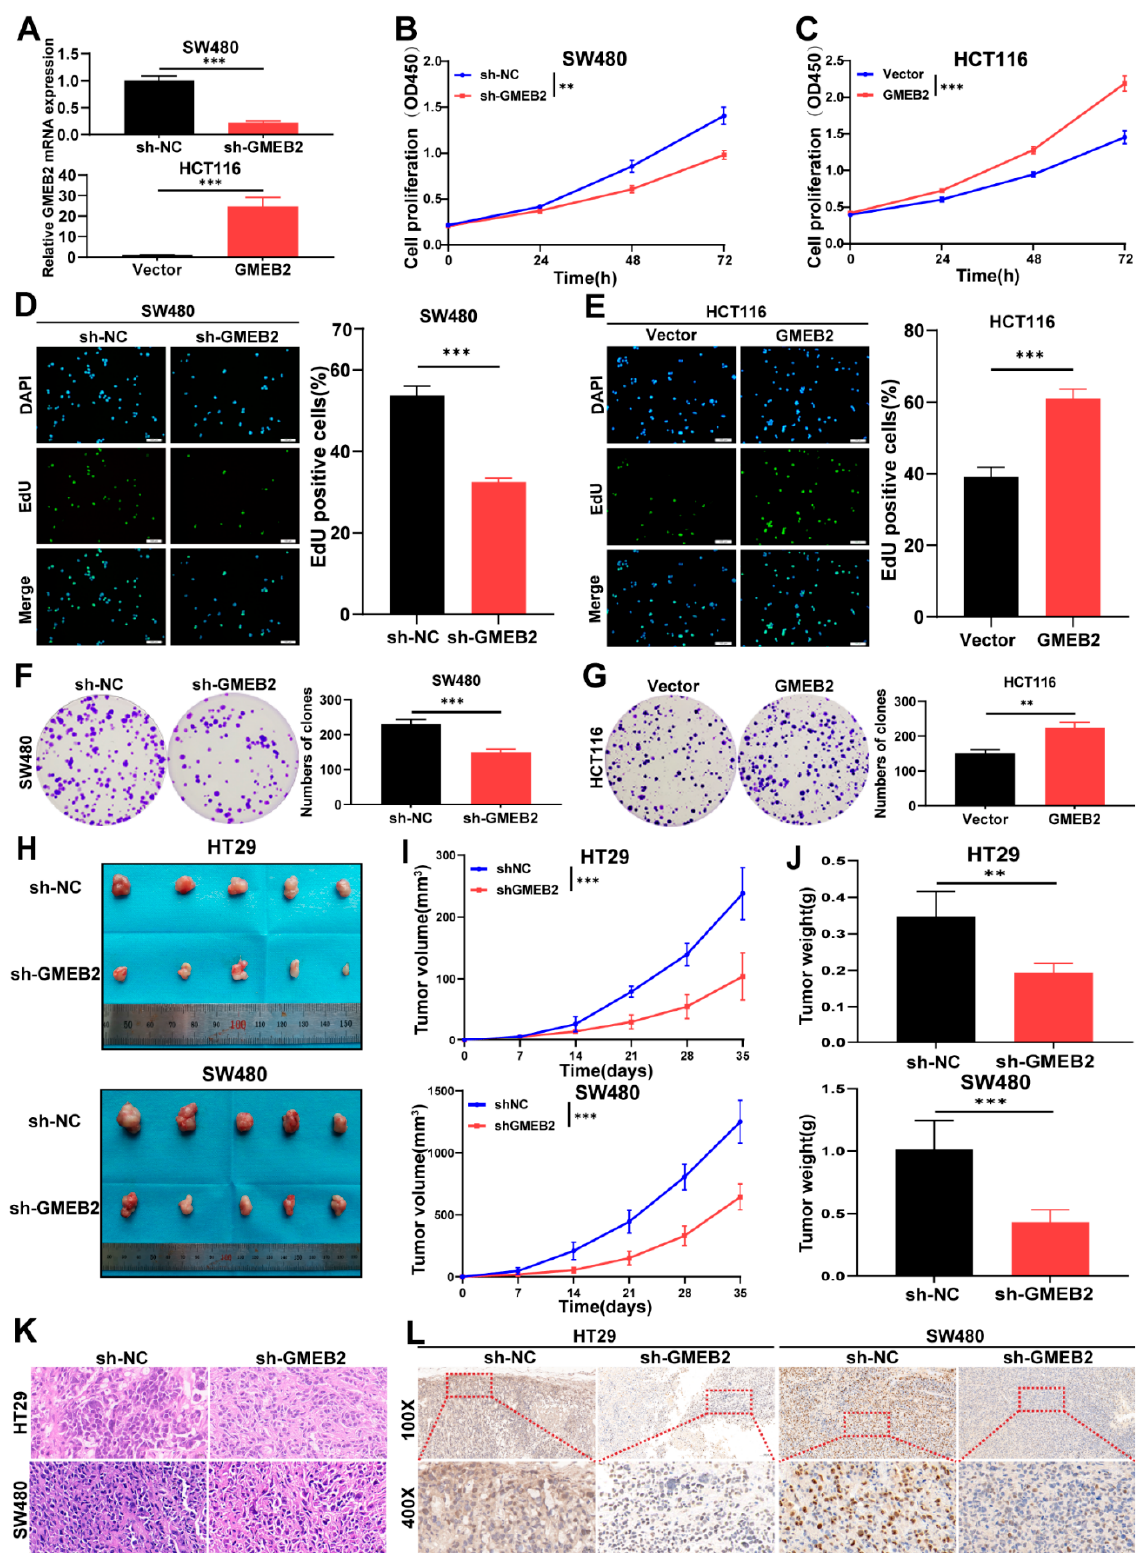
Figure 2. GMEB2 facilitates CRC cell growth in vitro and in vivo. ( A ) Silencing or overexpression efficiencies of GMEB2 in SW480 and HCT116 cells measured by qRT ‒ PCR (Student’s t -test, *** p < 0.001). ( B , C ) CCK-8 assays were used to detect the proliferation of SW480 and HCT116 cells after knockdown or overexpressing GMEB2 (two-way ANOVA, ** p < 0.01, *** p < 0.001). ( D , E ) EdU as- says and the relative quantitative results of cell proliferation are shown in histogram form (Student’s